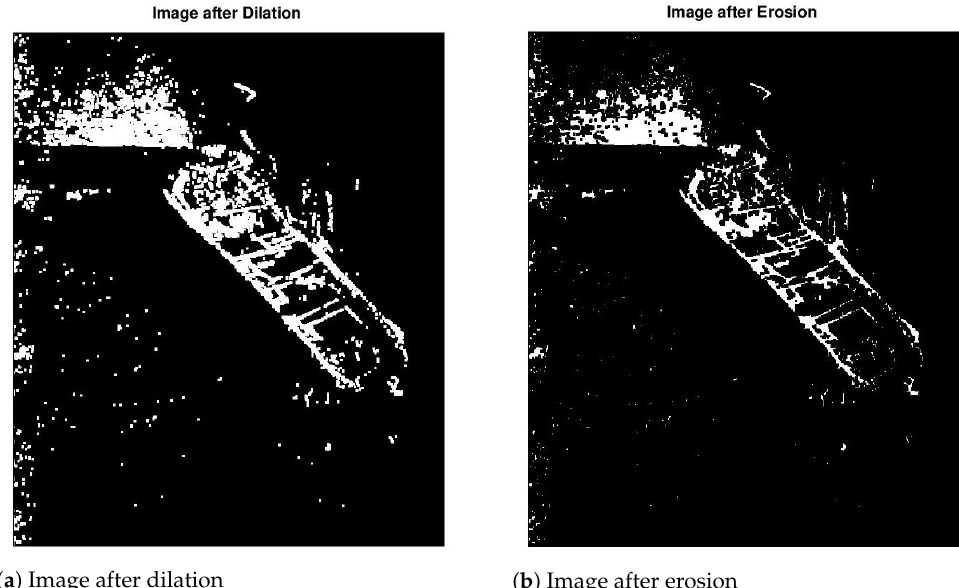
Figure 20. Result of corrosion expansion on the image of Figure